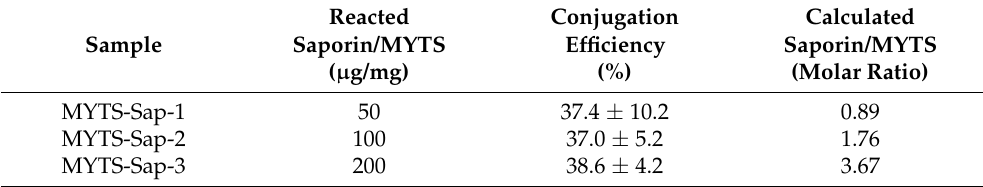
Table 2. Quantification of Saporin conjugation in MYTS-Sap-1, MYTS-Sap-2 and MYTS-Sap-3. Conju- gation efficiencies are expressed as the means of three independently synthesized batches ±